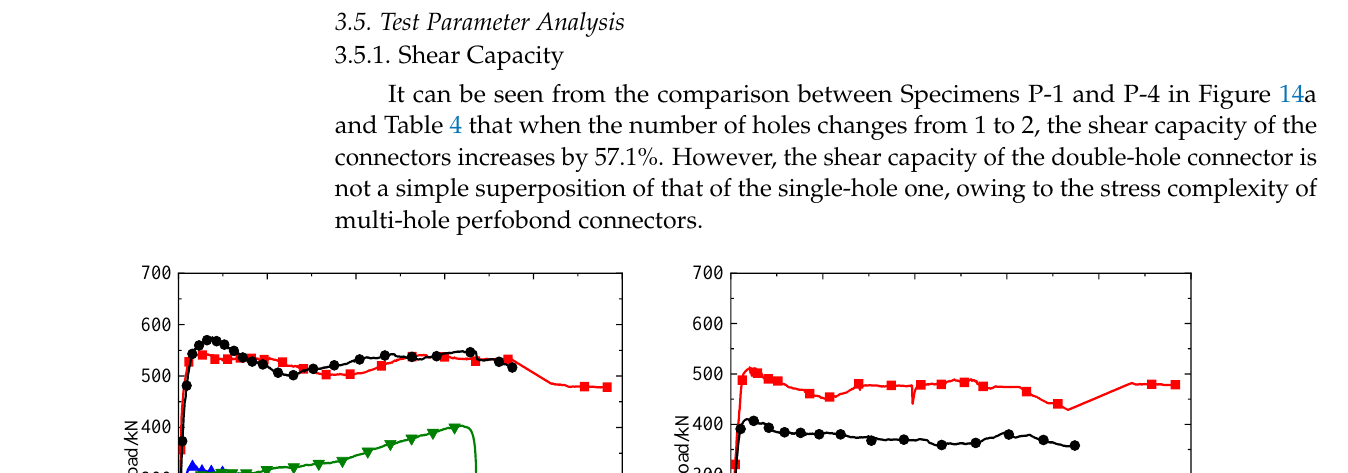
Figure 15. Effect of stirrup form on load – slip curves.